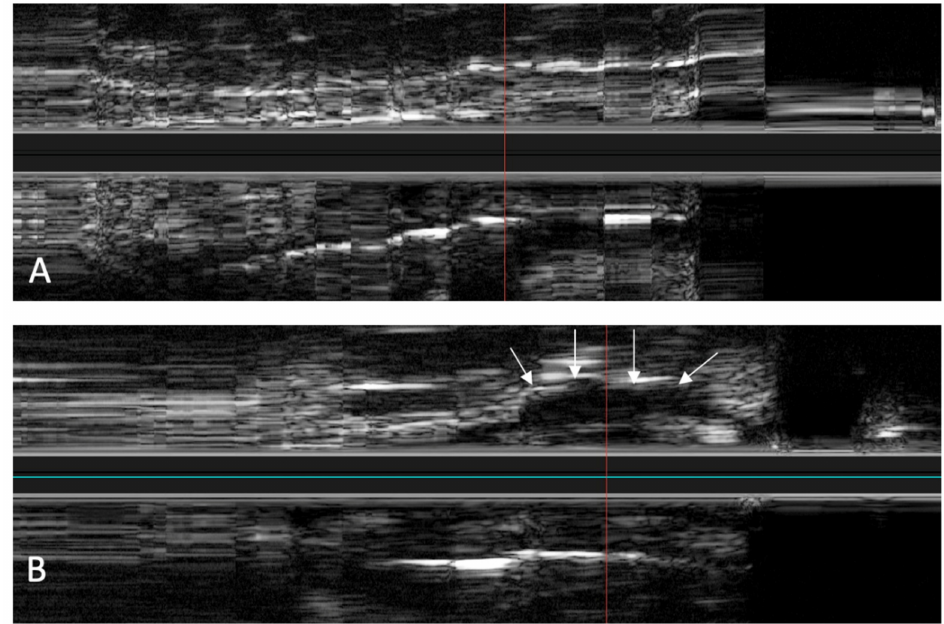
Figure 10. In vivo longitudinal ultrasound image of the ET before ( A ) and after ( B ) placement of an HA depot. In ( B ), the HA depot is anechogenic next to the tubal lumen (marked by the white